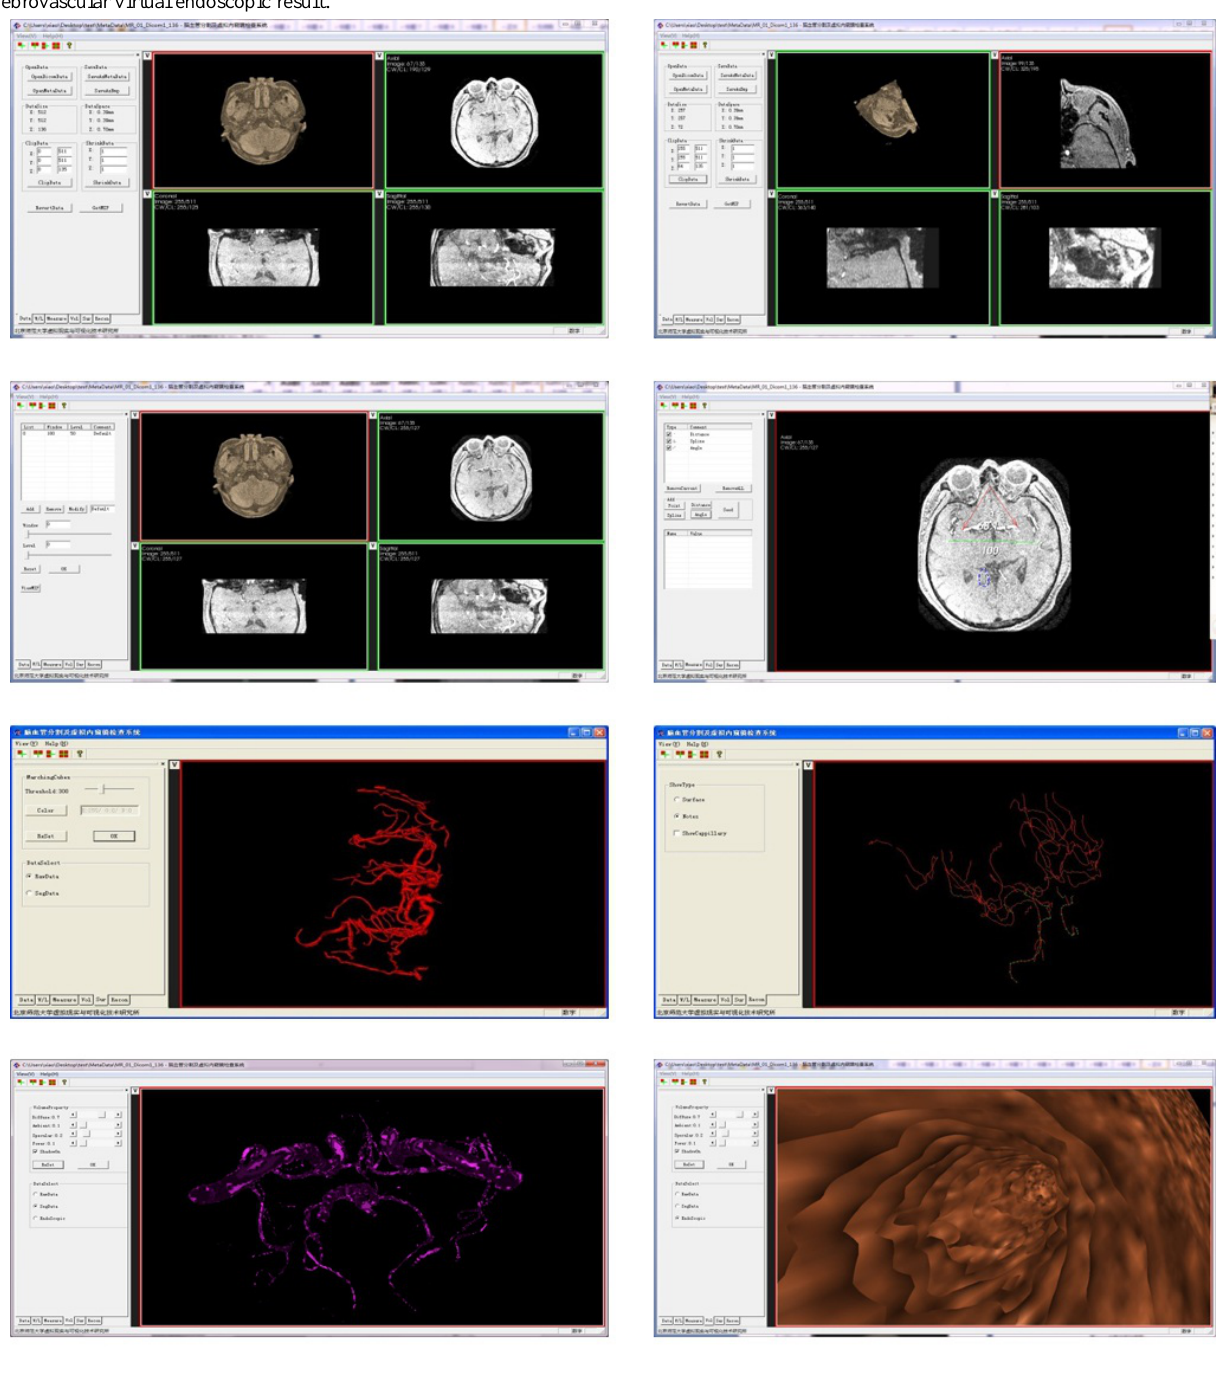
Figure 15. The function introduction of the platform. Descriptions for each row are from left to right. Row 1: an imported image of brain data; the cropping result of the brain image data. Row 2: window and width adjustment of the data with clear view effect; 2D measurement of the brain image. Row 3: statistical segmentation result of the cerebral vessels; reconstruction result of Balls B-spline method. Row 4: volume rendering result; cerebrovascular virtual endoscopic